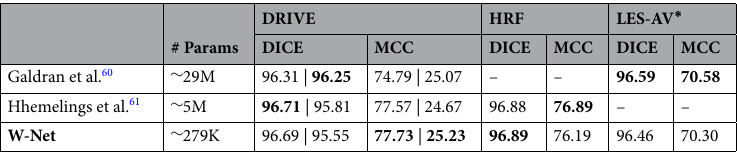
Table 5. Performance comparison for the artery/vein segmentation task. For DRIVE, performance is reported on the entire image domain | on a ring-shaped region around the Optic Disc 61 . Performance is computed using the predictions and code provided by 61 . ∗ Predictions on LES-AV are generated from models trained on DRIVE.